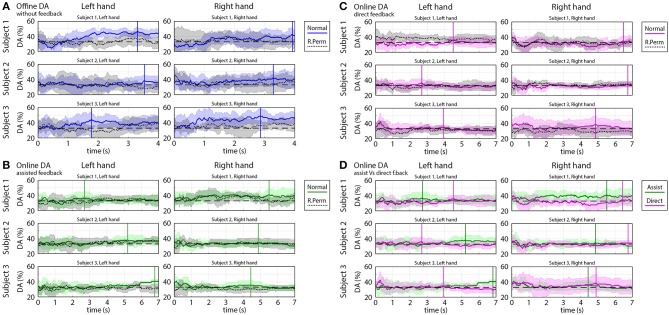
Time-varying decoding accuracy (DA) of predicted trajectories in offline and online parts of the experiments. The time-varying DA plots show how varying the ratio of the “successful” and “un-successful” target classifications over time during a movement cycle from the home position to a target position. DA values were calculated based on predicted coordinates of the virtual hand as described in the Methods section. (A) Offline DA without feedback. (B) Online DA with assisted feedback. (C) Online DA with direct feedback. (D) Comparison of online DA using assisted vs. direct feedback. (A–D) present the mean value (colored line) and standard deviation (colored shaded area) of the time-varying DA and (A–C) present also the results of the permutation test (mean: black dotted line, standard deviation: gray shaded area). DA peaks obtained during task periods are indicated in (A–D) with vertical solid lines. The chance level (33.3% for 3-class classification) is denoted by a black dashed line.